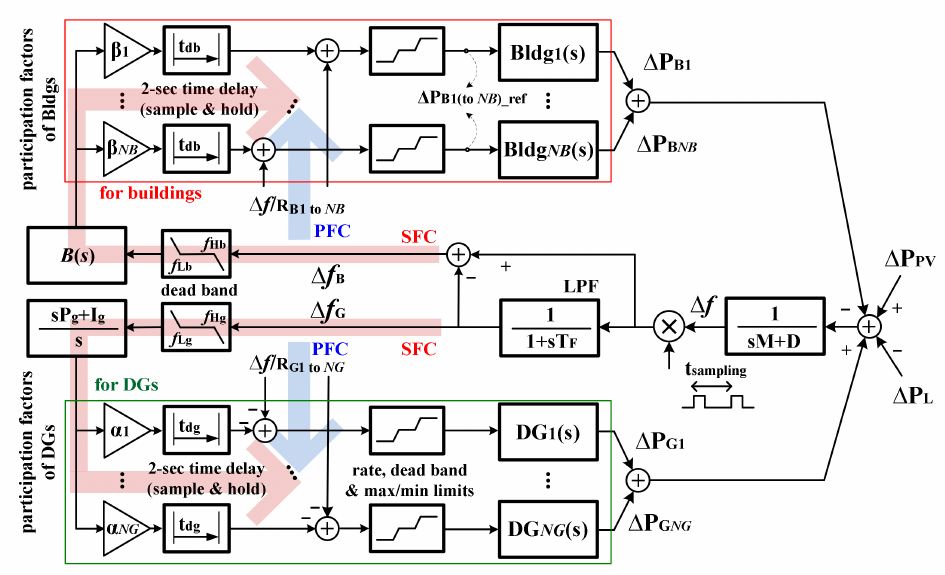
Figure 14. A block diagram of the ancillary service provision by buildings including EV